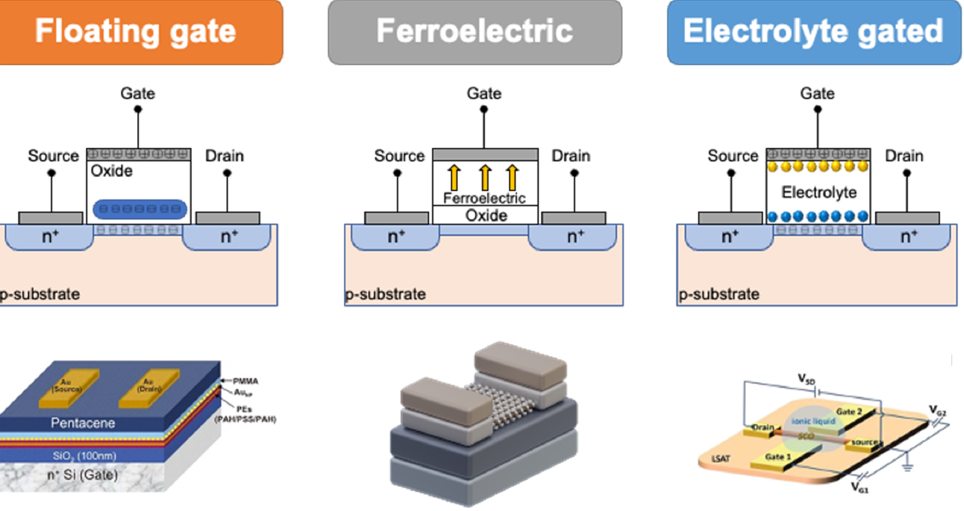
Figure 7. Schematic diagram for the three typical prototypes for the synaptic transistors, floating- gate, ferroelectric, and electrolyte-gated transistors [115–120]. Reprinted/adapted with permission